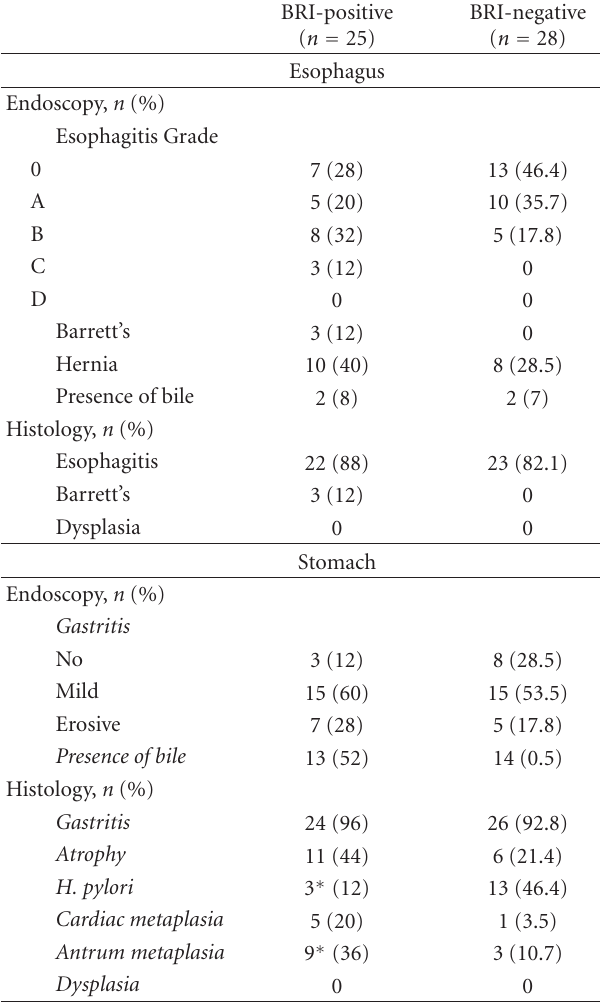
Table 4: Endoscopic and histologic data in BRI-positive and BRI- negative GERD patients.